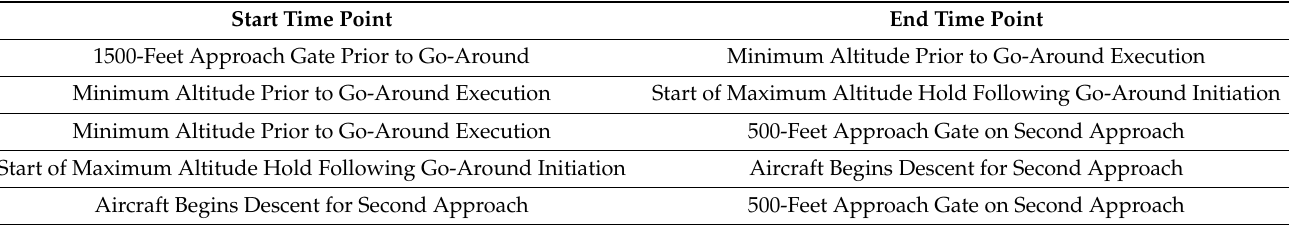
Table 2. Summary of the time-series features